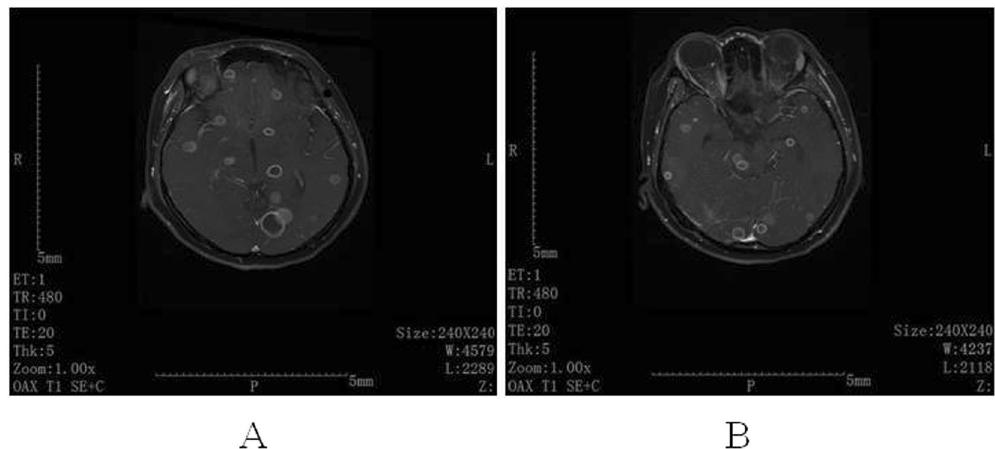
Figure 2. Cerebral enhanced MRI of case 17. ( A ) Multiple nodular and annular enhanced lesions in cerebrum and cerebellum. ( B ) Multiple nodular and annular enhanced lesions in cerebrum, cerebellum and brainstem.